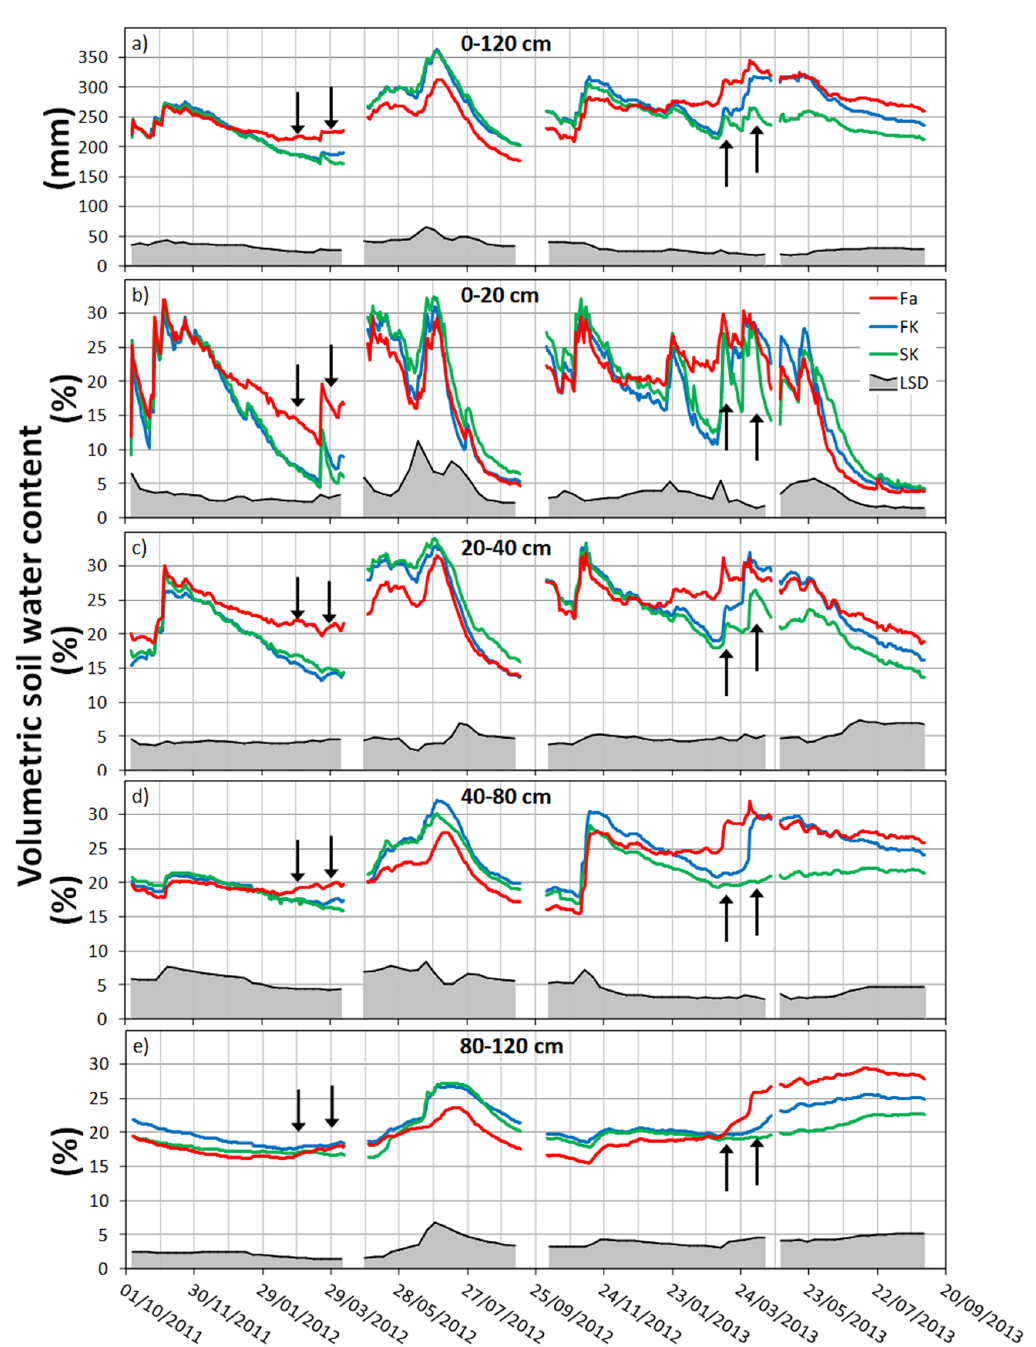
Figure 7. Soil water content monitored with the capacitance sensors at different depths for the fallow (Fa), first kill (FK) and second kill (SK) treatments during the experimental period. Arrows represent the first and second kill dates. The shadowed area in the bottom represents the LSD at 0.05 probability level.